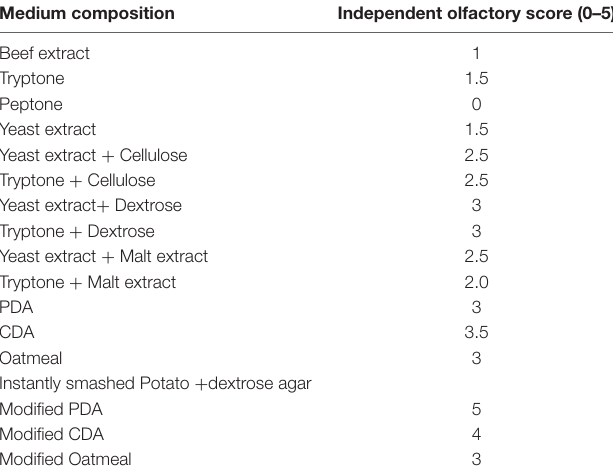
TABLE 3 | Anti-fungal activity of an 8-day old endophytic fungus against selected TABLE 4 | Effect of medium compositions on VOCs production by endophytic fungal pathogens. fungi with qualitative olfactory observations obtained from independent ratings of 0–5, 5 being the maximum. Fungal pathogens Inhibition (%) IC 50 of artificial IC 50 as µ L after 168 h of atmosphere after mL − 1 of air treatment a 72 h of treatment ( µ L space needed 50 mL − 1 ) for 50% inhibition b Geotrichum candidum 67.1 ± 0.8